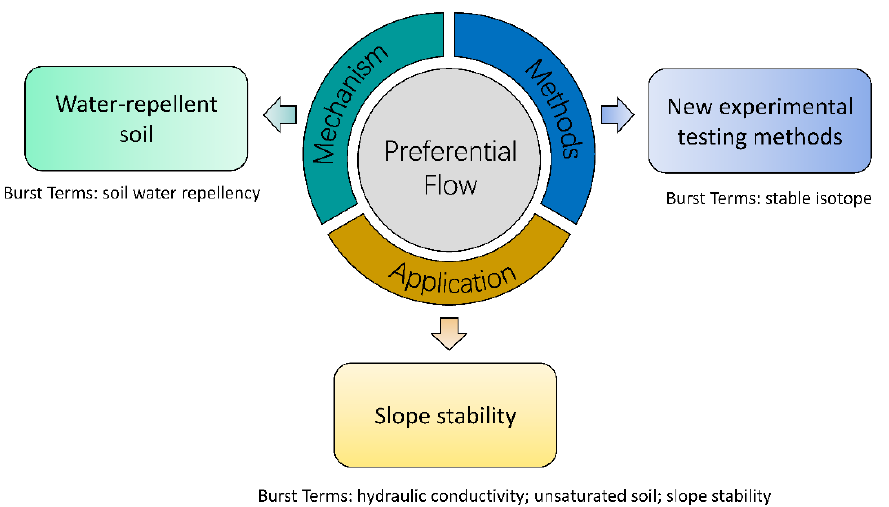
Figure 9. Three research hotspots.